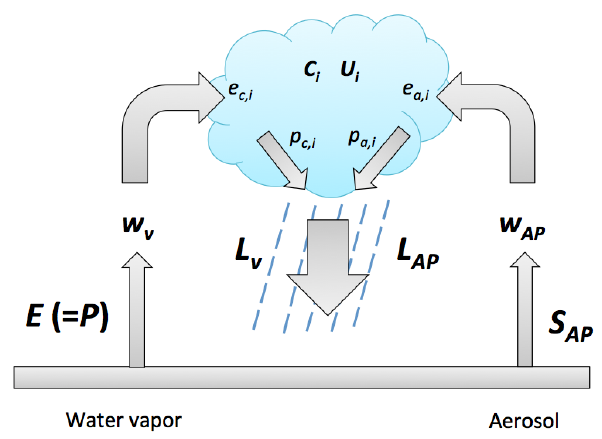
Figure 1. Atmospheric cycles of water vapor and soluble aerosol. The symbols are explained in Section 2.1.